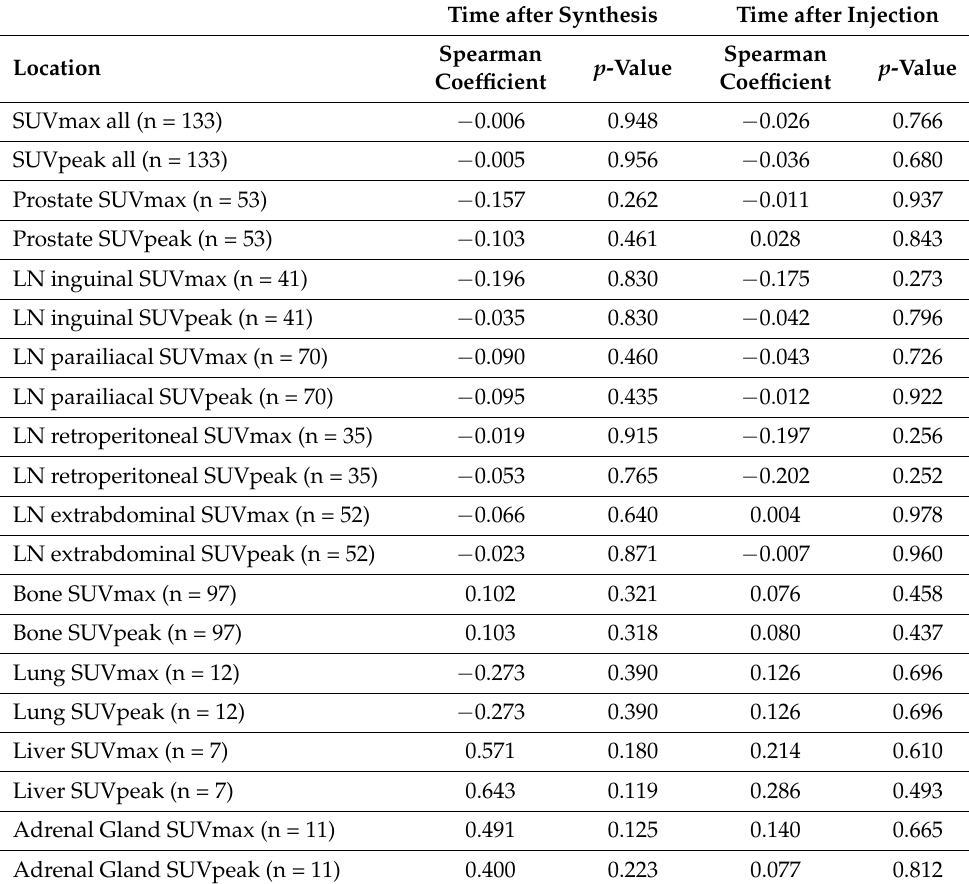
Time after Synthesis Time after Injection Spearman Spearman p -Value p -Value Coefficient Coefficient